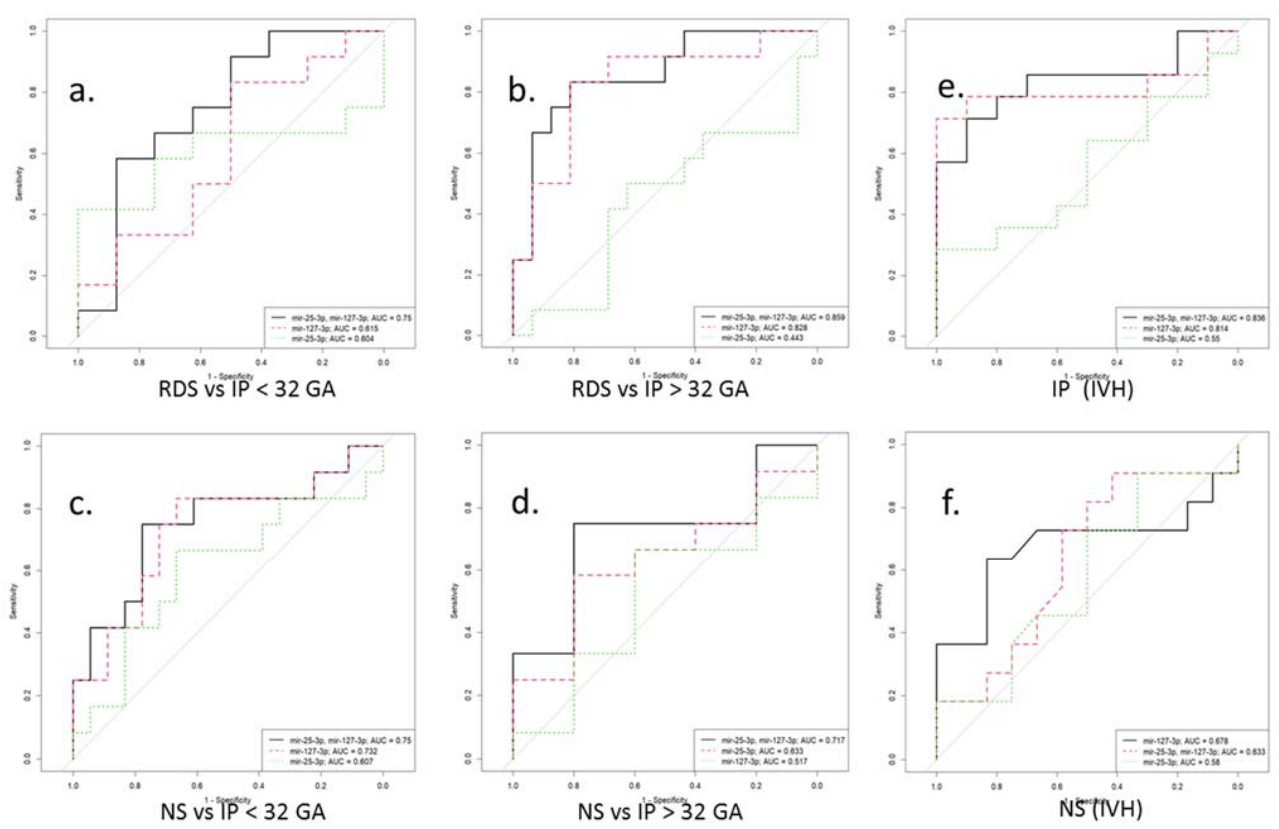
Figure 5. ROC curves for a logistic model for the differential diagnosis of perinatal outcomes ( a – d ) by miR-25-3p and miR-127-3p expression in blood plasma of newborns before (<32) and after (>32) gestational age (GA). ROC curves for a logistic model for the risk assessment IVH by miR-25-3p and miR-127-3p expression in blood plasma of newborns with IP ( e ) and NS ( f ) before 32 gestation weeks. RDS is respiratory distress syndrome. IP is intrauterine pneumonia. NS is neonatal sepsis. IVH is intraventricular hemorrhage.